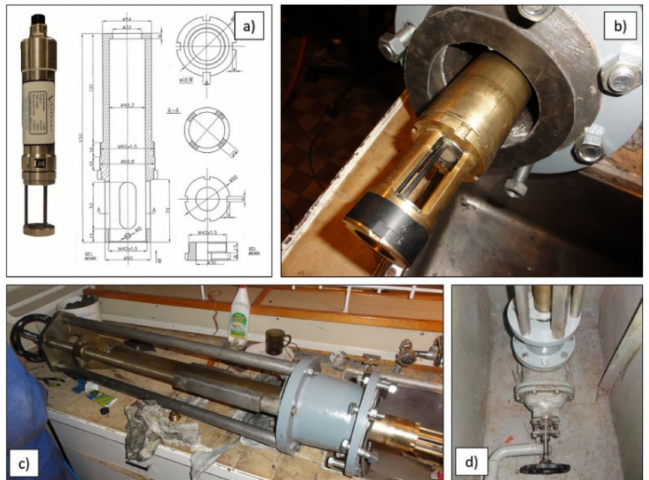
Figure 16. Components of the technical solution implemented on board Polish Navy hydrographic ship Arctowski . ( a ) Sound velocity sensor and technical design of brass tube; ( b ) sensor mounted in the tube attached to the log lifter; ( c ) modernized log lifter; ( d ) valve in the bottom of the ship’s